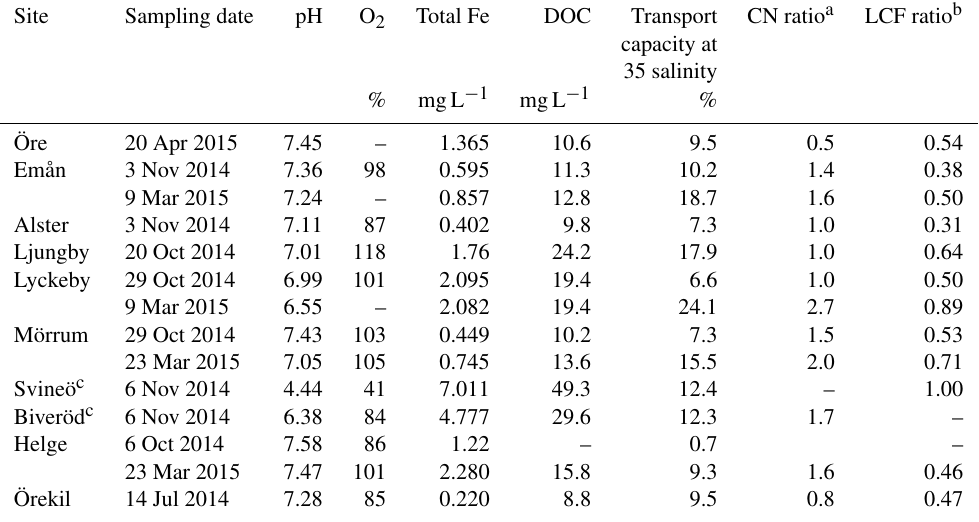
Table 2. Water chemistry and transport capacity at salinity 35 (corresponding to the salinity of the open sea) of collected samples. Site